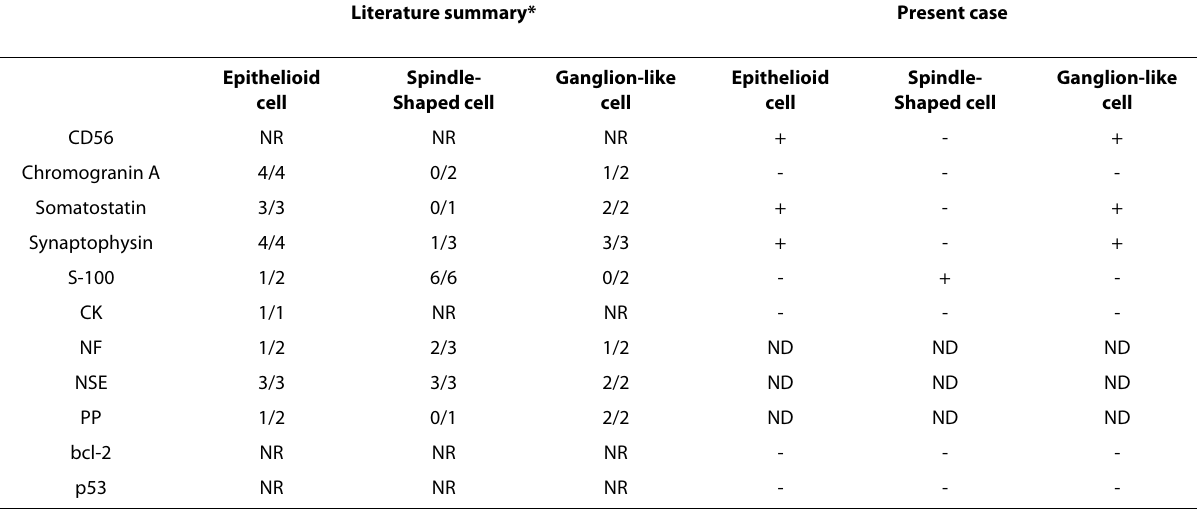
Table 2: Summary of phenotypical expression analysis by immunohistochemical examination Literature summary*